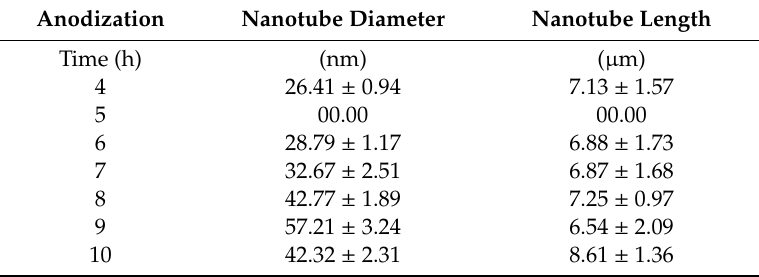
Table 1. Diameter and length measurements of the nanotubes formed on the surface of the Ti-30Ta alloy a SEM images of Ti-30Ta alloy surface after anodization process in NH 4 F 0.25% + glycerol at 30 V for 4, 5, 6, 7, 8, 9, and 10 h. The annealing process was performed at 530 °C (5 °C/min) for 1 h. Anodization